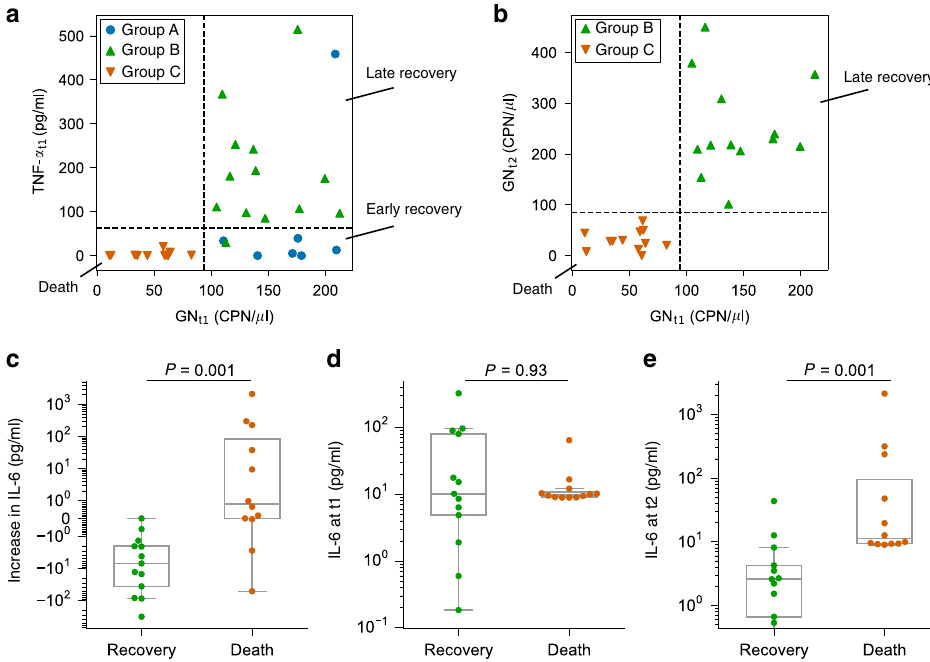
Fig. 5 Accurate classi fi cation of septic shock patient outcomes. a Decision-tree classi fi cation shows that the patients can be classi fi ed with excellent accuracy using GN bacteria load and TNF- α level at time point t 1 (the dashed lines represent the decision-making thresholds). b The level of GN bacteria at time points t 1 and t 2 in groups B and C also showed distinct separation thresholds (dashed lines). c – e Temporal changes of IL-6 ( c ), and the IL-6 levels at time point t 1 ( d ) and time point t 2 ( e ) of the patients who recovered (group B) ( n = 13) or died (group C) ( n = 12) from septic shock. In ( a ), the classi fi cation accuracies for groups A ( n = 7), B ( n = 13), and C ( n = 12) are 85.71%, 92.31%, and 100%, respectively. Note that the scale of the y axis in ( c ) is symmetric and logarithmic. ( c – e ) Two-sided Mann – Whitney U test with Benjamini – Hochberg